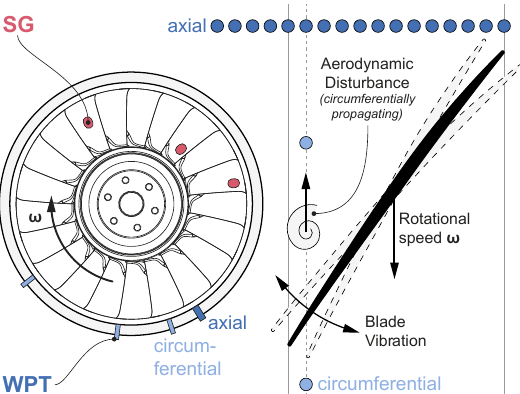
Figure 2. Unsteady instrumentation within the rotor